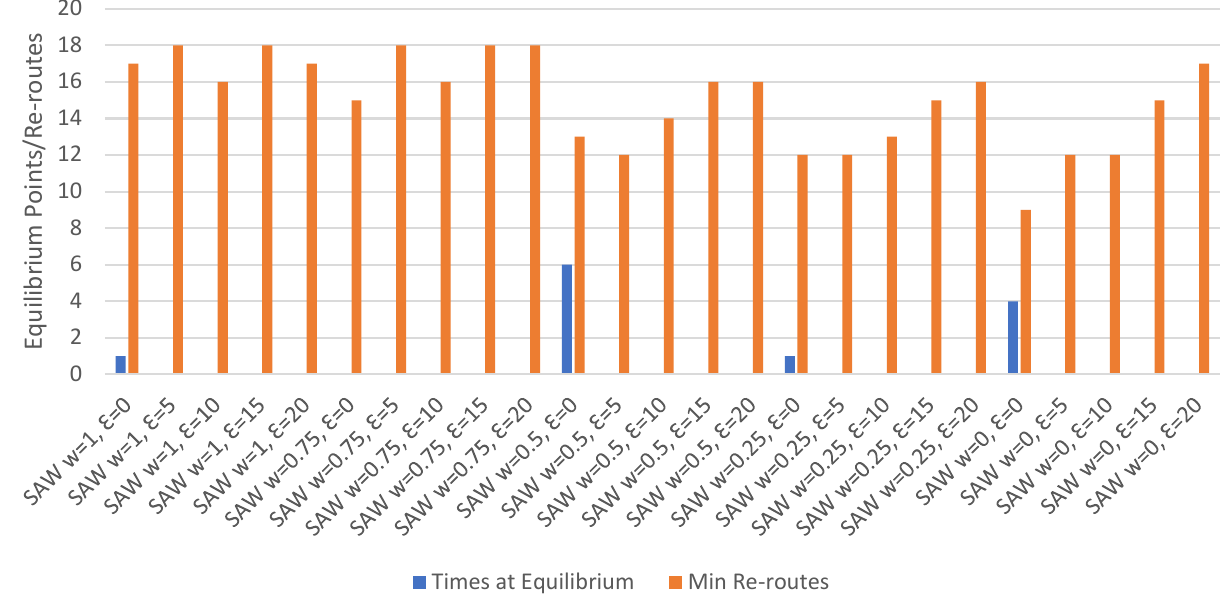
Figure 7. Equilibrium points and re-routes with direct